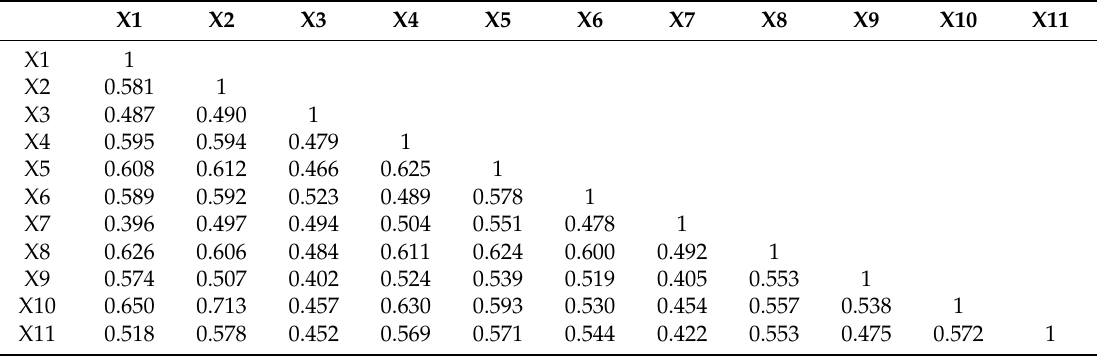
Table 3. The relevance test of the economic output indicators of green technology innovation.